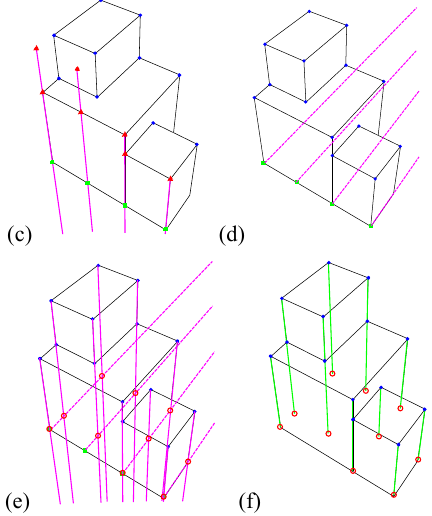
Figure 4. An example of base point prediction.